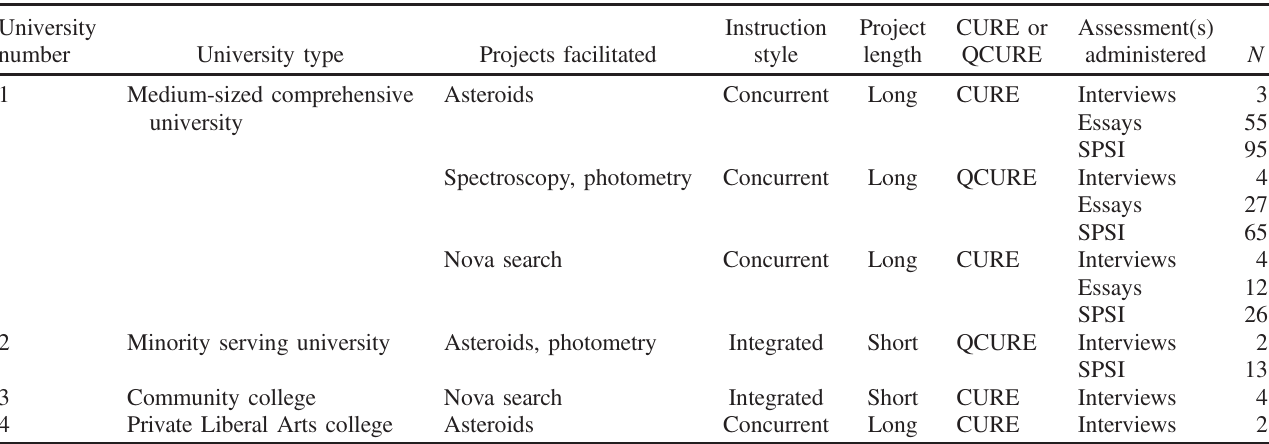
TABLE I. Assessments administered by type of university, project, and